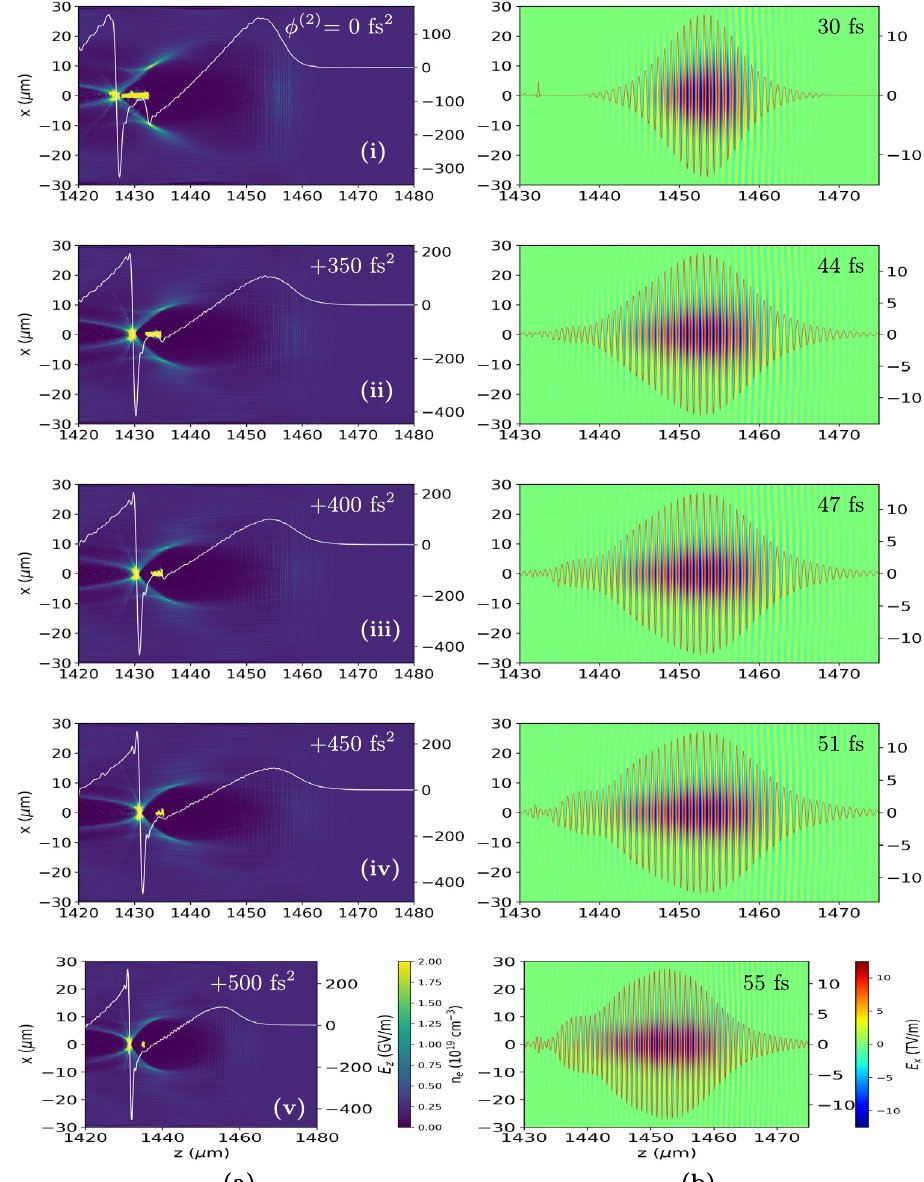
FIG. 1. Particle-in-cell simulations illustrating controlled electron injection using plasma density modulation. (a) Electron density distribution at different group delay dispersion ( ϕ ð 2 Þ , noted in the graph) of laser pulses. (b) The laser electric field distribution corresponding to ϕ ð 2 Þ with the red line describing the on-axis laser field. The FWHM pulse duration of the laser pulse is indicated in the